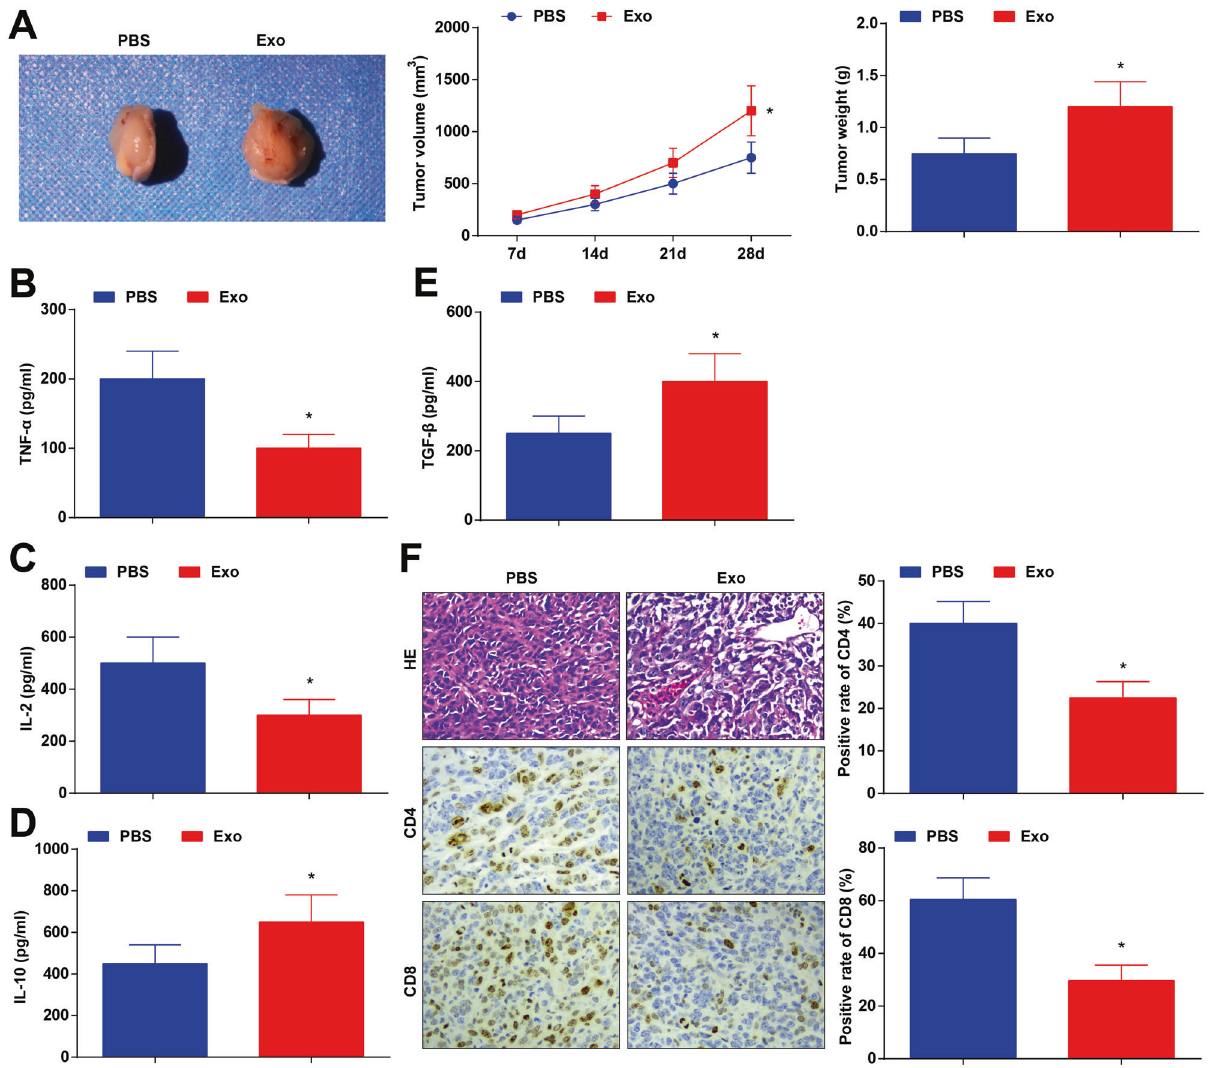
Fig. 3 CRCSC-exos reduce anti-tumor immunity in CRC. A Representative images, volume, and weight of xenografts from mice after exosome treatment; B – E TNF- α , IL-2, IL-10, and TGF- β contents in mouse serum were determined using ELISA 72 h after exosome injection; F the histological characteristics of tumor tissues detected using HE staining; CD4 and CD8 expression in xenografts from mice detected using immunohistochemistry after exosome treatment. There were fi ve mice in each group; * P < 0.05 vs the PBS group; the measurement data were expressed as mean ± standard